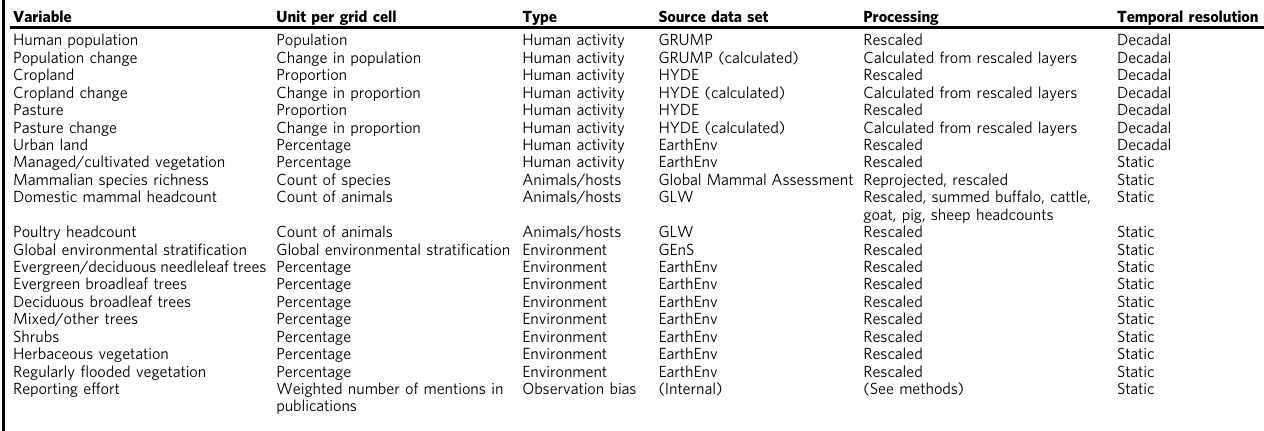
Table 1 List of predictor layers included in the model